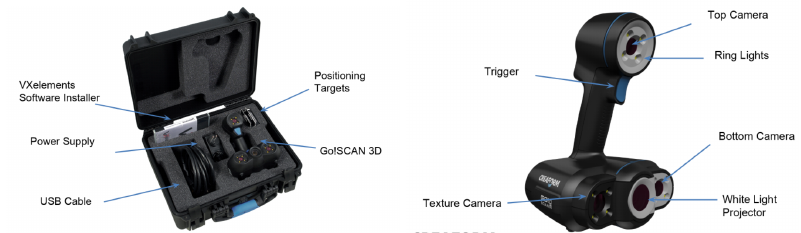
Figure 5. ( Left ): Go!scan 20 package, ( right ): Go!scan 20 3D